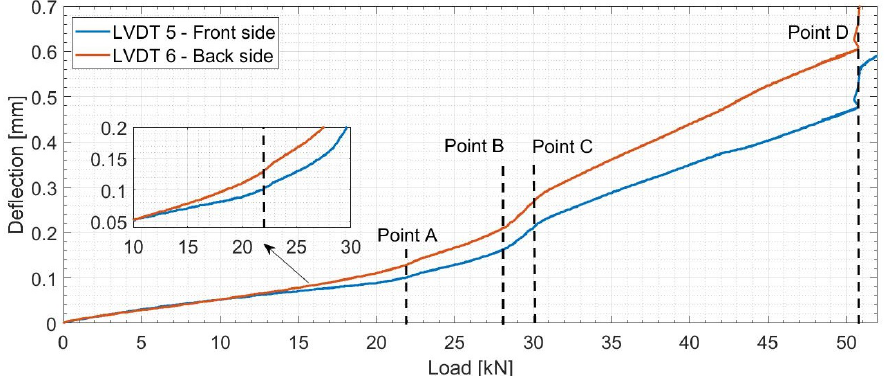
Figure 7. Variation of the vertical deflection in the central part of the beam measured by Linear Variable Differential Transformers (LVDT)